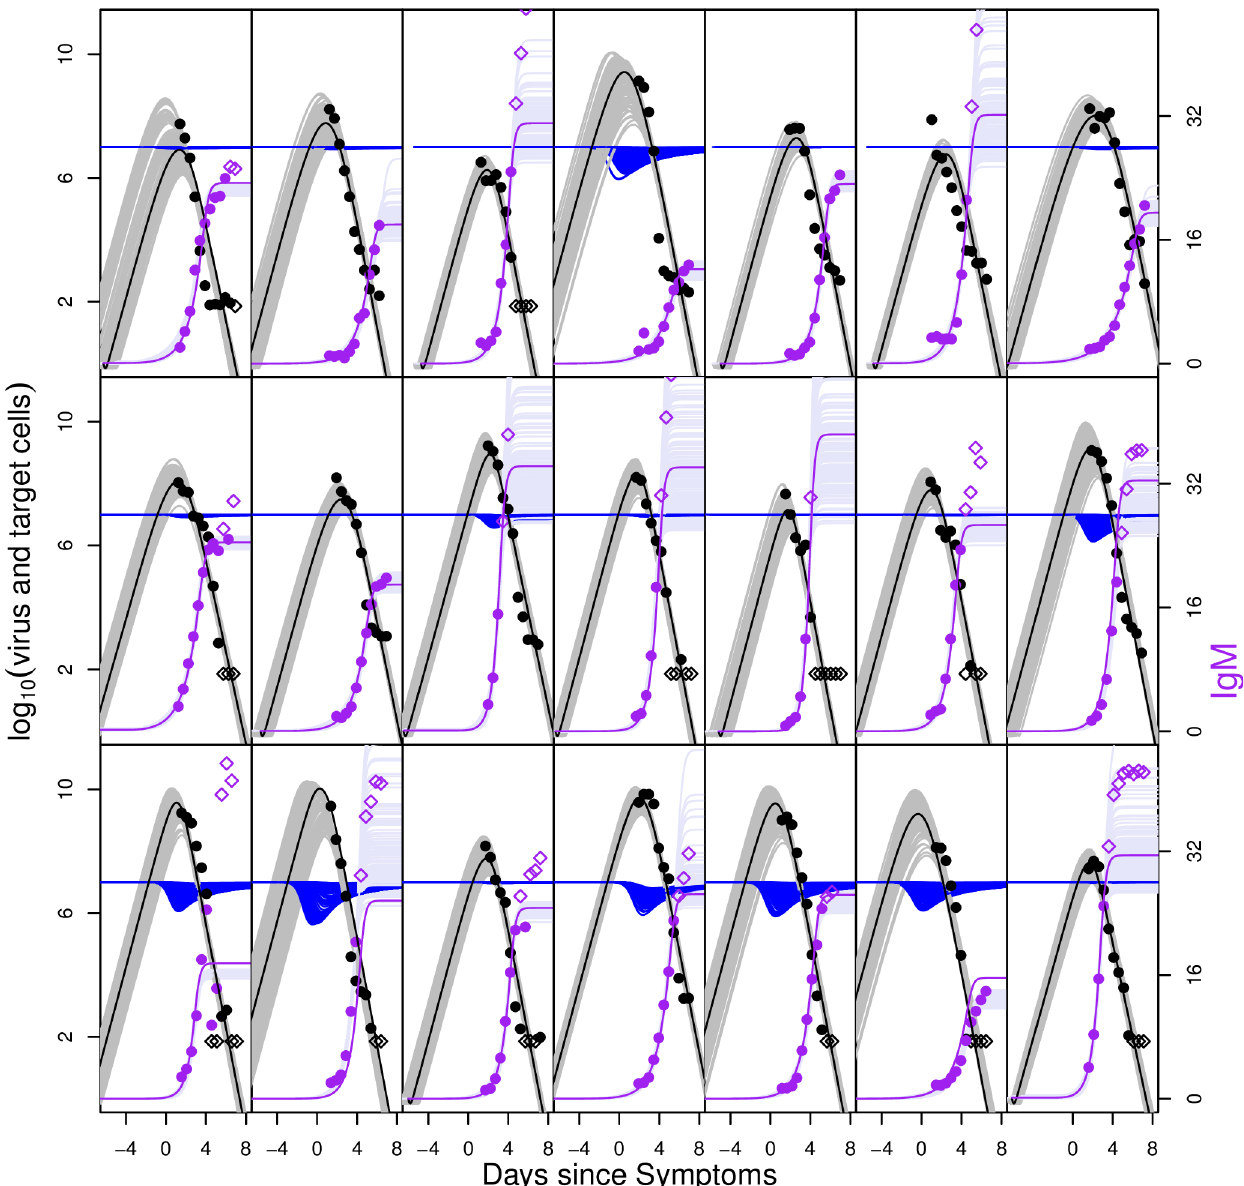
Fig 4. As Fig 3 but for DENV2-infected subjects. Fit of the model to virus and IgM measurements for DENV1-infected subjects for the model variant in which antibody removed virus. Each plot shows an individual patient. Virus data is shown in black and IgM data in purple. Parameters z 0 , η 1 , η 2 , IP and SF fitted as patient specific, other parameters fitted per group. Mauve, grey and blue curves show 100 samples from the posterior distributions of antibody, virus and target cell trajectories, respectively. Median fits are shown as bold lines (purple shows IgM, black shows virus). Parameter estimates are shown in Table 2. All subjects were classified as secondary